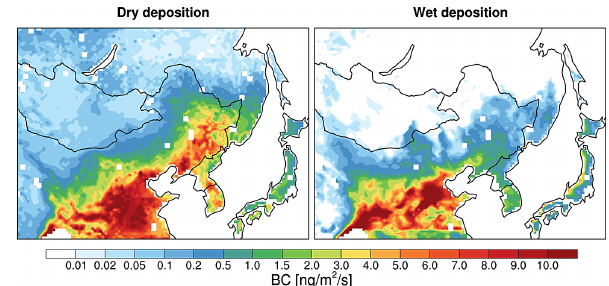
Figure 6. Spatial distribution of dry and wet deposition fluxes of BC on snow from the WRF-Chem simulations over North China in January–February